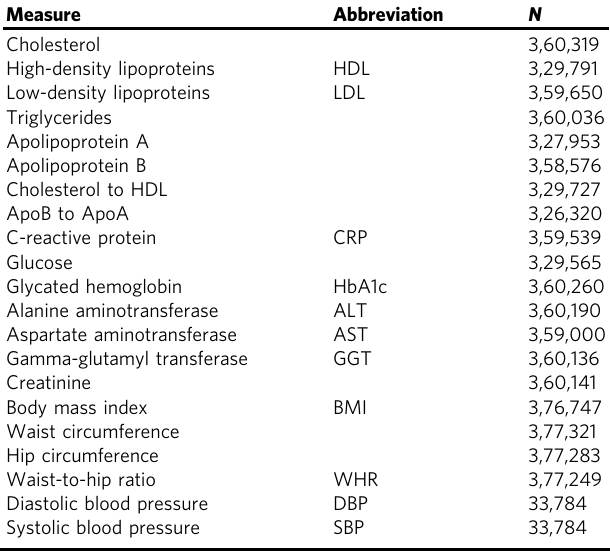
Table 2 Measures of cardiometabolic health used in the secondary analyses, together with abbreviations and maximum available sample